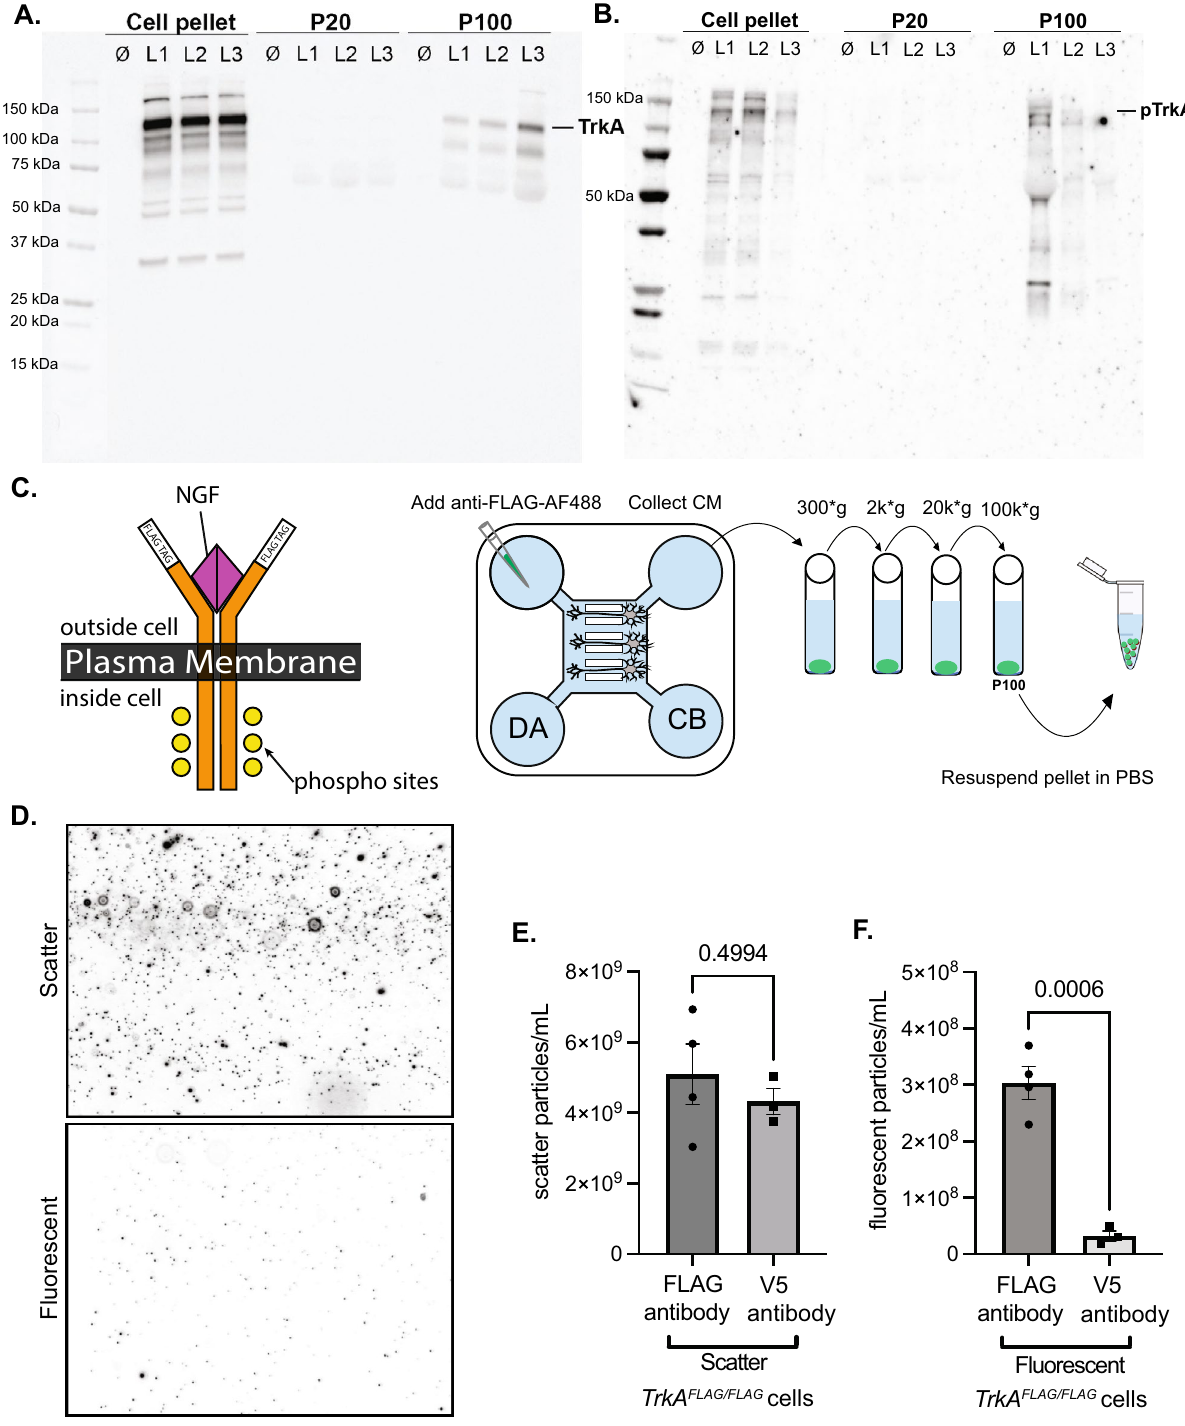
Figure 4. Somatodendritically secreted sympathetic EVs contain the TrkA receptor that originated in the distal axon and was transported retrogradely to the soma. ( A ) , ( B ) Full immunoblot analysis of TrkA and phosphorylated TrkA (Y-490) in cell pellets, P20 and P100 EV fractions from three independent litters (L1, L2, L3) and a “no cell” media control ( ∅ ). Note : the three litters from ( A ) are different from the three litters from ( B ). ( C ) Schematic showing the topology of FLAG-TrkA expressed from the mouse knockin locus in TrkA FLAG/FLAG mice (NGF: magenta triangle, phosphorylation sites: yellow circles). Sympathetic neurons from TrkA FLAG/FLAG mice were grown in MFDs. Anti- FLAG-AF488 antibody was fed to the distal axons (DA) and 15 h later CM was collected from the cell body (CB) compartment and EVs were isolated by differential centrifugation. ( D ) Still frames captured from NTA videos at t = 30 secs in scatter (top) and fluorescent (Anti-FLAG-AF488 + ) (bottom) mode. ( E ) , ( F ) Quantification of the number of scatter or fluorescent (AF488 +) particles detected after either Anti-FLAG-AF488 or V5-AF488 addition to the DA chamber of MFDs containing TrkA FLAG/FLAG SCG neurons. Shown is the mean ± SEM for four biological replicates. P values are indicated above the pairwise